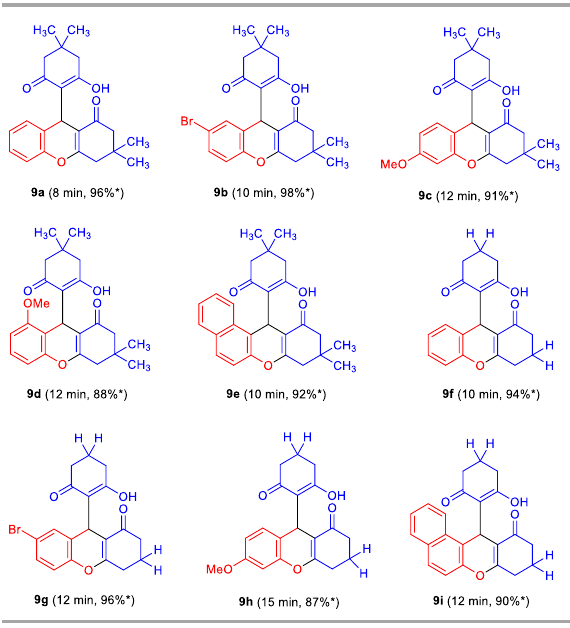
Table 6. Substrate scopes for the synthesis of tetrahydro-1 H -xanthen-1-one 9a–i . Reaction condition: Salicylaldehydes 8a–e (1.0 mmol), and 5,5-dimethylcyclohexane-1,3-dione 3a /cyclohexane-1,3-dione 3b